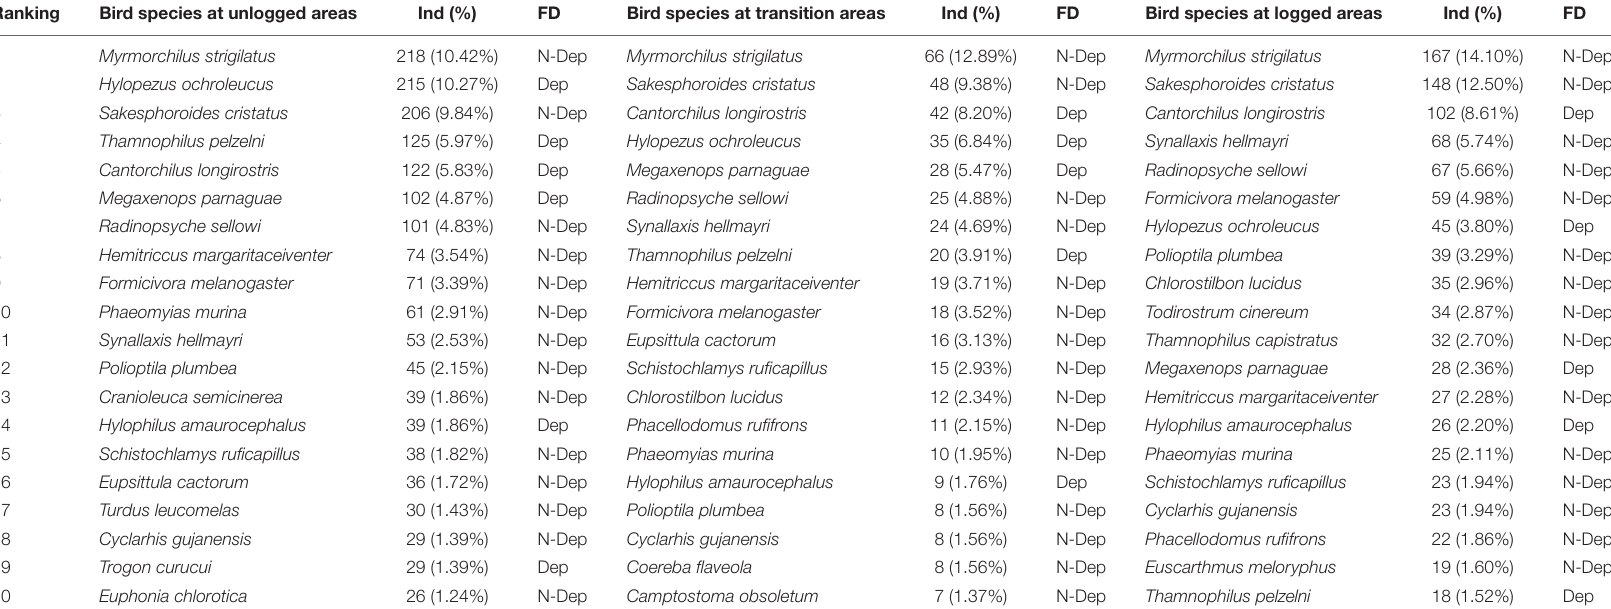
TABLE 2 | The 20 most detected bird species in 160 point counts conducted in 23 half-trails of the management area at Fazenda Pau D’Arco, Crato, Ceará,